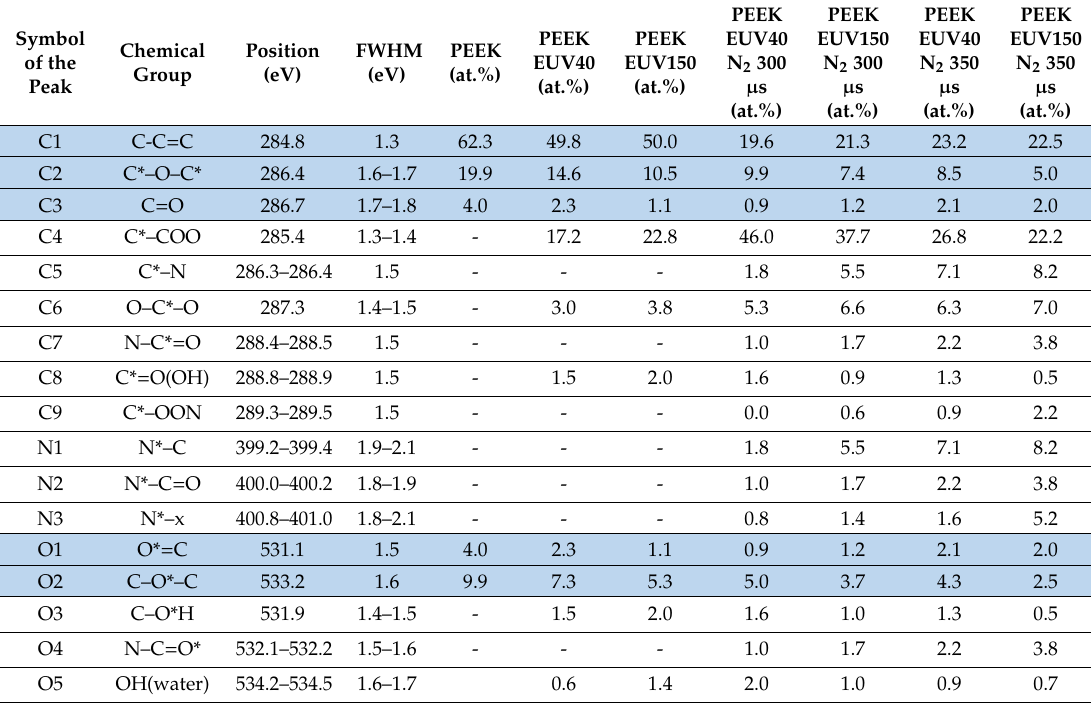
Table 1. Binding energy range, FWHM range, and atomic concentration of di ff erent functional groups for pristine PEEK and modified